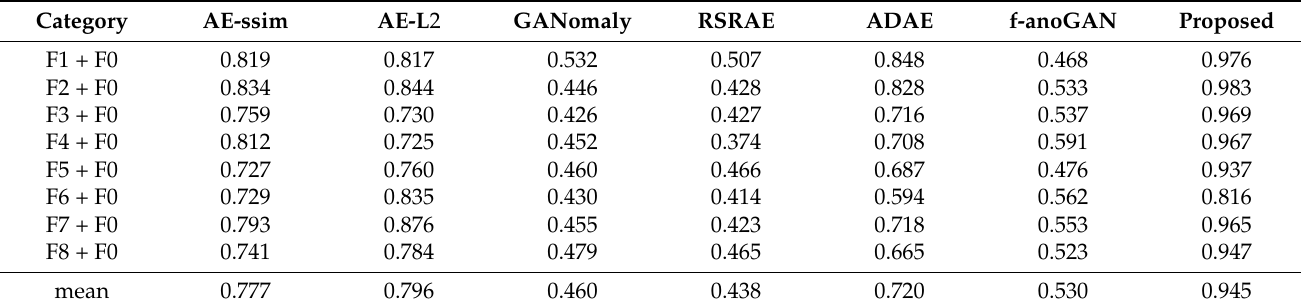
Table 4. Quantitative comparisons with other methods (AUROC).